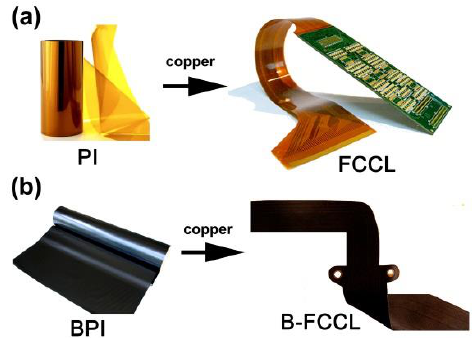
Figure 1. Applications of black polyimide (PI) films in flexible copper clad laminates (FCCLs).